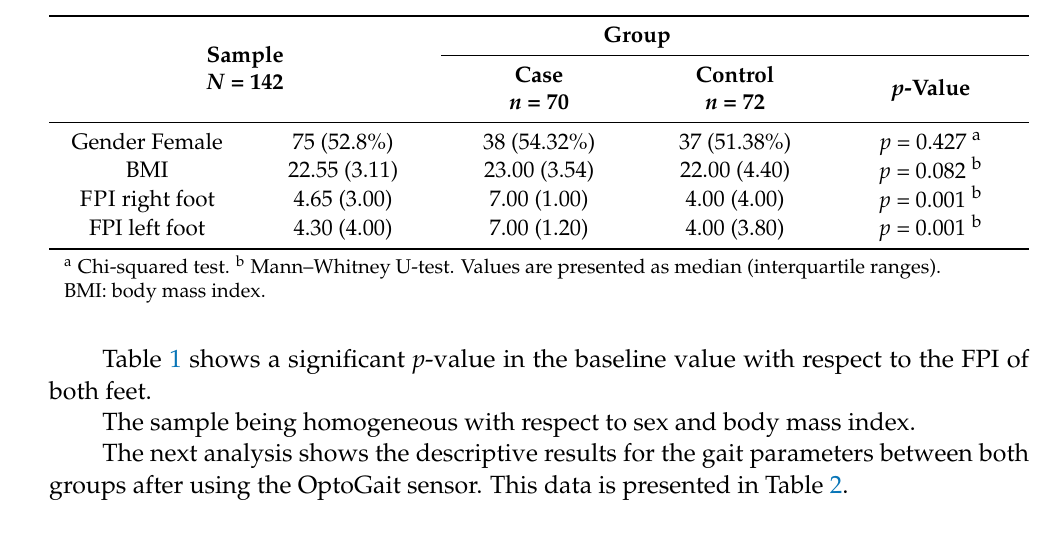
Table 1. Whole sample demographic values of the demographic variables for both groups. The foot posture index for right and left feet was showed (foot posture index (FPI)) (average ± standard deviation) are